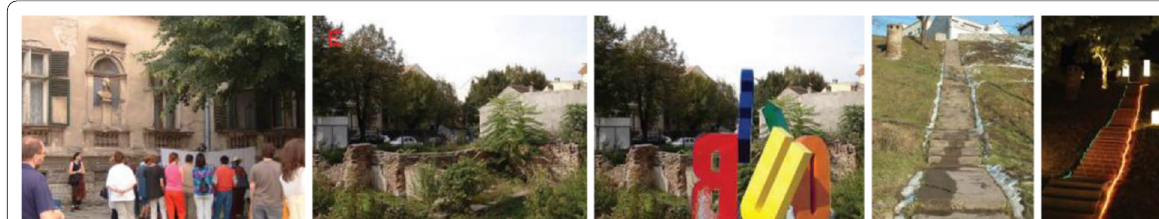
Fig. 10 Public art interventions at Kosančićev venac